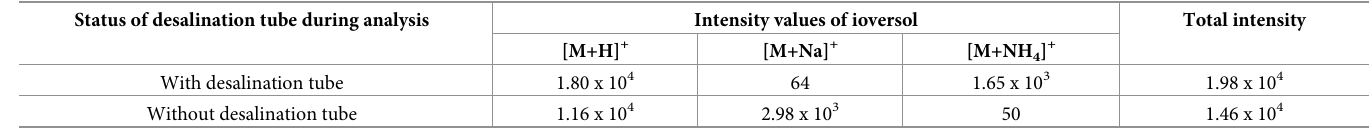
Table 2. Q-TOF MS data for the evaluation of ioversol adsorption by desalination tube. Status of desalination tube during analysis